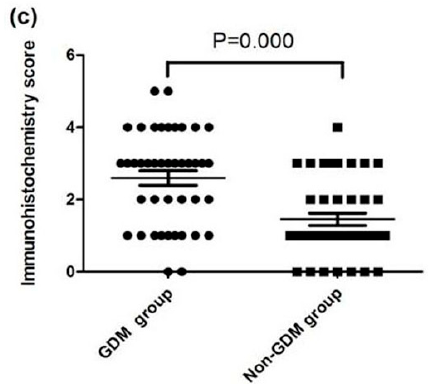
Figure 1. Immunohistochemistry images demonstrated that FPN1 was higher expressed on the membrane of STB cells of fetal surface(as arrows) from the GDM group ( a ) than that in non-GDM group ( b , as arrows) (×200 magnification); Immunohistochemistry score was higher in the GDM group compared with the non-GDM group ( c , p = 0.000).